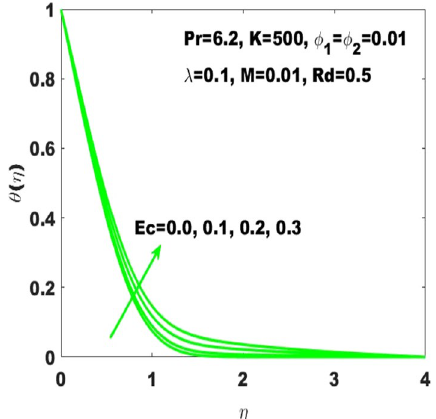
Figure 7. θ ( η ) for diverse values of